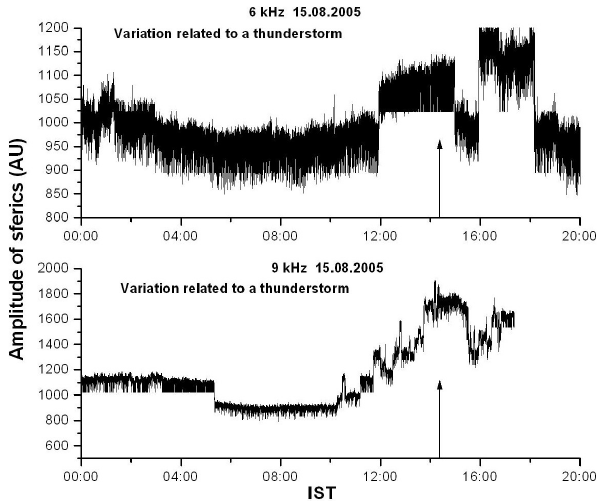
Fig. 7. A typical record of sferics at 6kHz and 9kHz during a thun- derstorm over North Tripura at a distance 75–100km. The arrow mark indicates the onset of rain associated with thunderstorm.